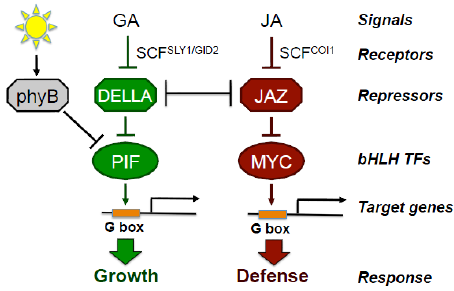
Figure 2. Simplified model depicting interactions between the JA, GA, and phyB signaling pathways. Points of positive and negative regulation are indicated by arrows and perpendicular lines, respectively. bHLH-TFs, basic helix-loop-helix transcription factors that bind G-box cis -regulatory elements typically located in the promoter region of response genes. In full sunlight, PIF transcription factors are inhibited by the active conformer of phyB. See text for details.